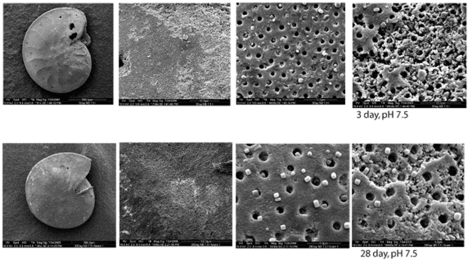
Representative electron micrographs of foraminifera shells incubated in dissolution experiment 2 (low nutrient treatment).Upper row shows one foraminifera after 3 days incubation. Whole animal is represented in the left hand panel, the other 3 panels represent various random positions on the shell. The lower row represents similar pictures of a shell incubated in the same treatment for 28 days. Note the heterogeneity in shell condition. Both shells show areas of shell degradation, and areas of no degradation. Similar results were observed for all shells at all treatment levels.